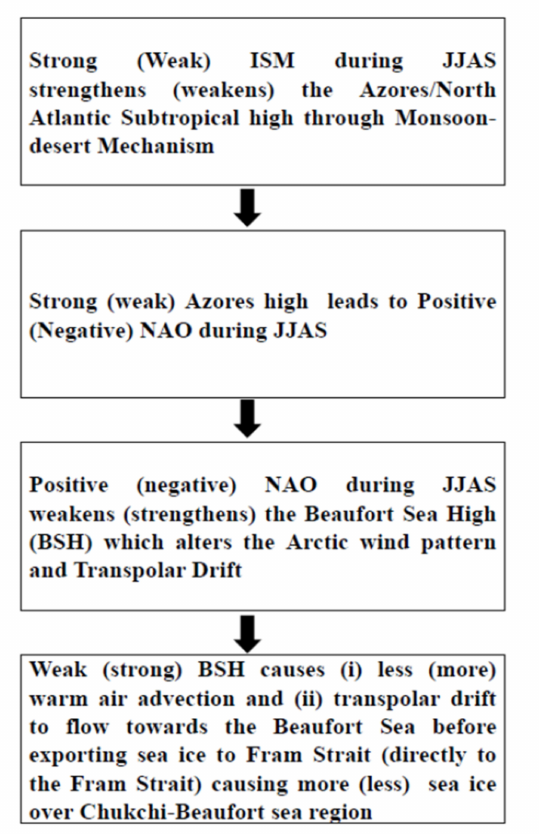
Figure 10. Schematic of the physical mechanism illustrating the link between ISM and Arctic Sea